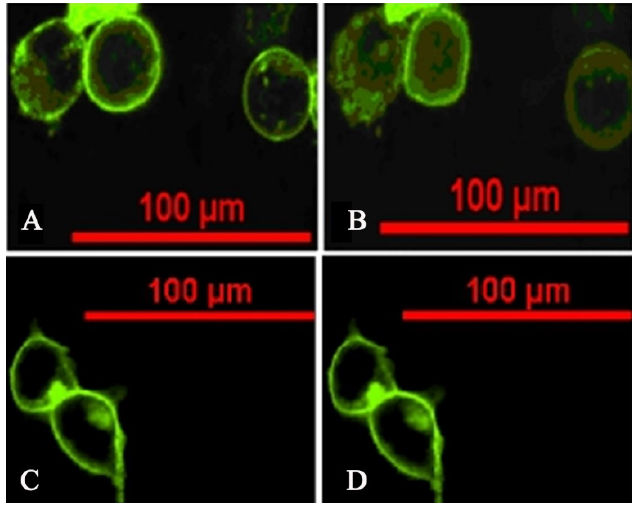
Figure 4. The invagination of TGR5 . ( A ) transfected 293T cells treated with TCDCA for 0 min; ( B ) 293T cells treated with TCDCA for 15 min, which is when the fluorescence was observed; ( C ) untransfected 293T cells treated with TCDCA for 0 min; ( D ) untransfected 293T cells treated with TCDCA for 15 min.